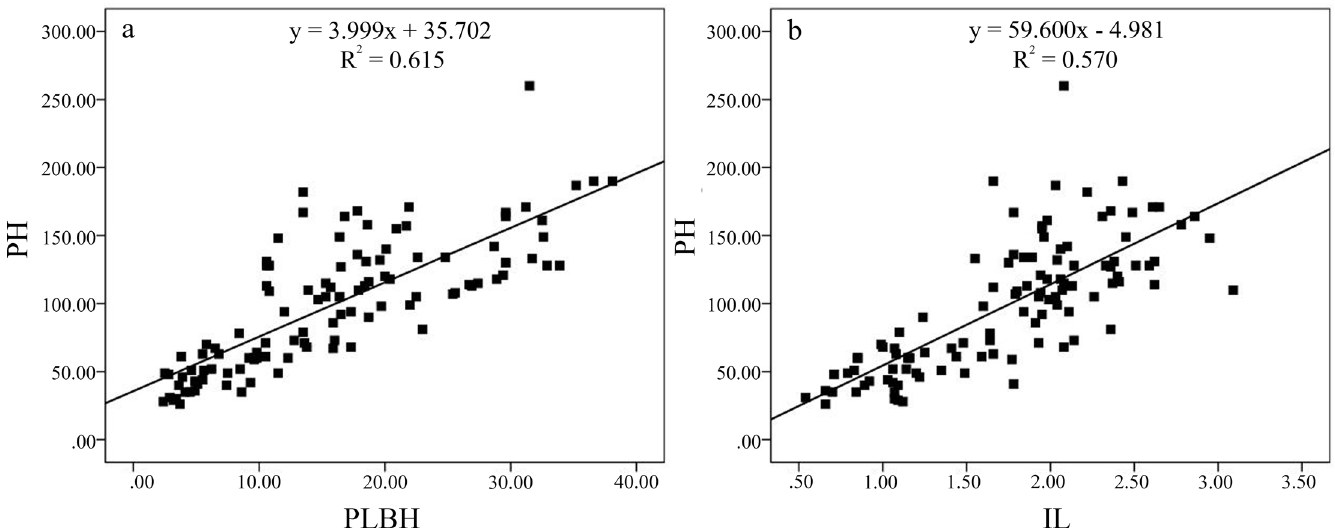
Fig 4. Scatter plots of the phenotypes in the F 1 population derived from Lagerstroemia fauriei (non-dwarf) × L . indica ‘ Pocomoke ’ (dwarf). The traits were evaluated for each individual with three replicates. All of the data analyses were conducted using the SPSS Statistics 20.0 program (SPSS, Chicago, IL, USA); P < 0.01. (a) PH and IL, and (b) PH and